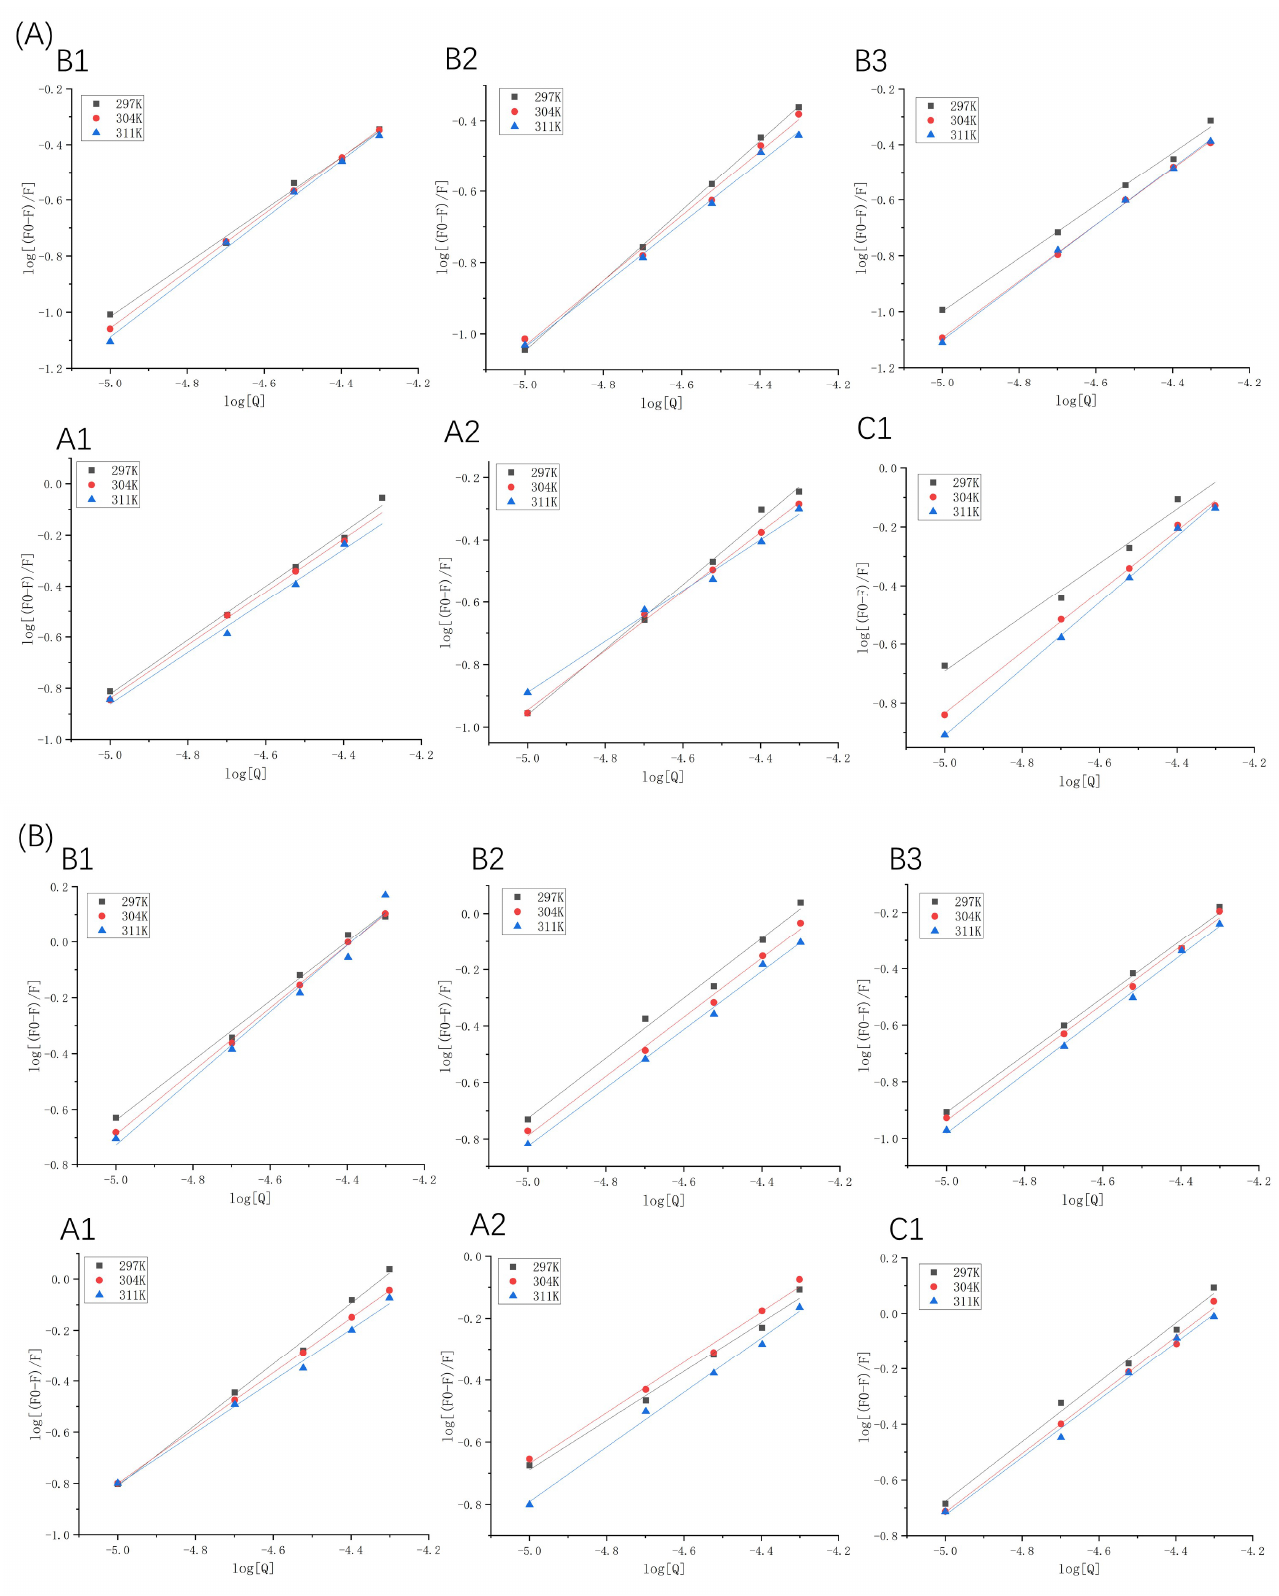
Figure 3. Double logarithmic Stern–Volmer plots of β -LG ( A ) or α -LA ( B ) quenched by proanthocyanidins A1, A2, B1, B2, B3, and C1 at 297 K, 304 K, and 311